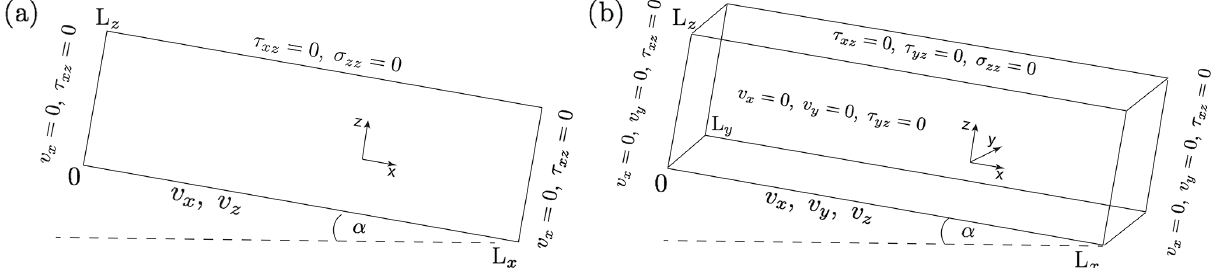
Figure 3. Model configuration for the numerical experiments: (a) 2-D model and (b) 3-D model. Both the surface and bed topography are flat but inclined at a constant angle of α . We show both the model coordinate axes and the prescribed boundary